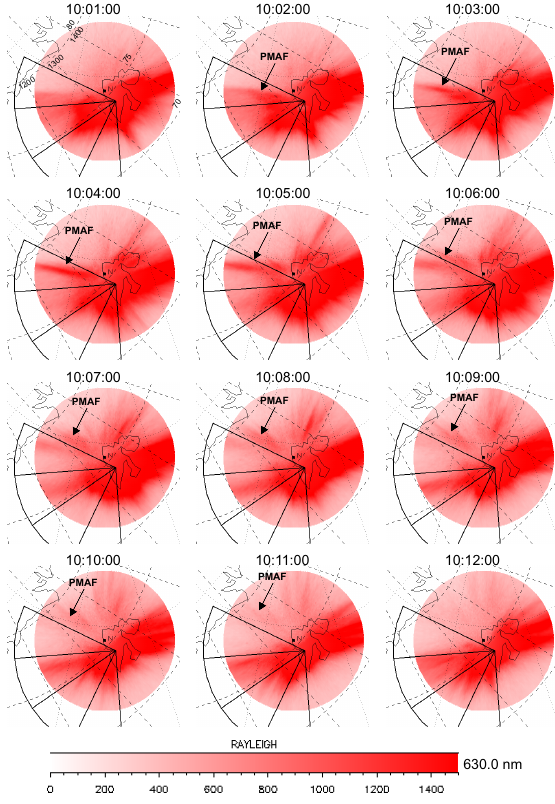
Fig. 5. Sequence of 557.7-nm (green line) all-sky images from the Ny- ˚Alesund AFRL camera showing the motion of the PMAF. The images are overlaid on a magnetic grid, and shown with solid lines is the EISCAT Svalbard radar’s field-of-view.